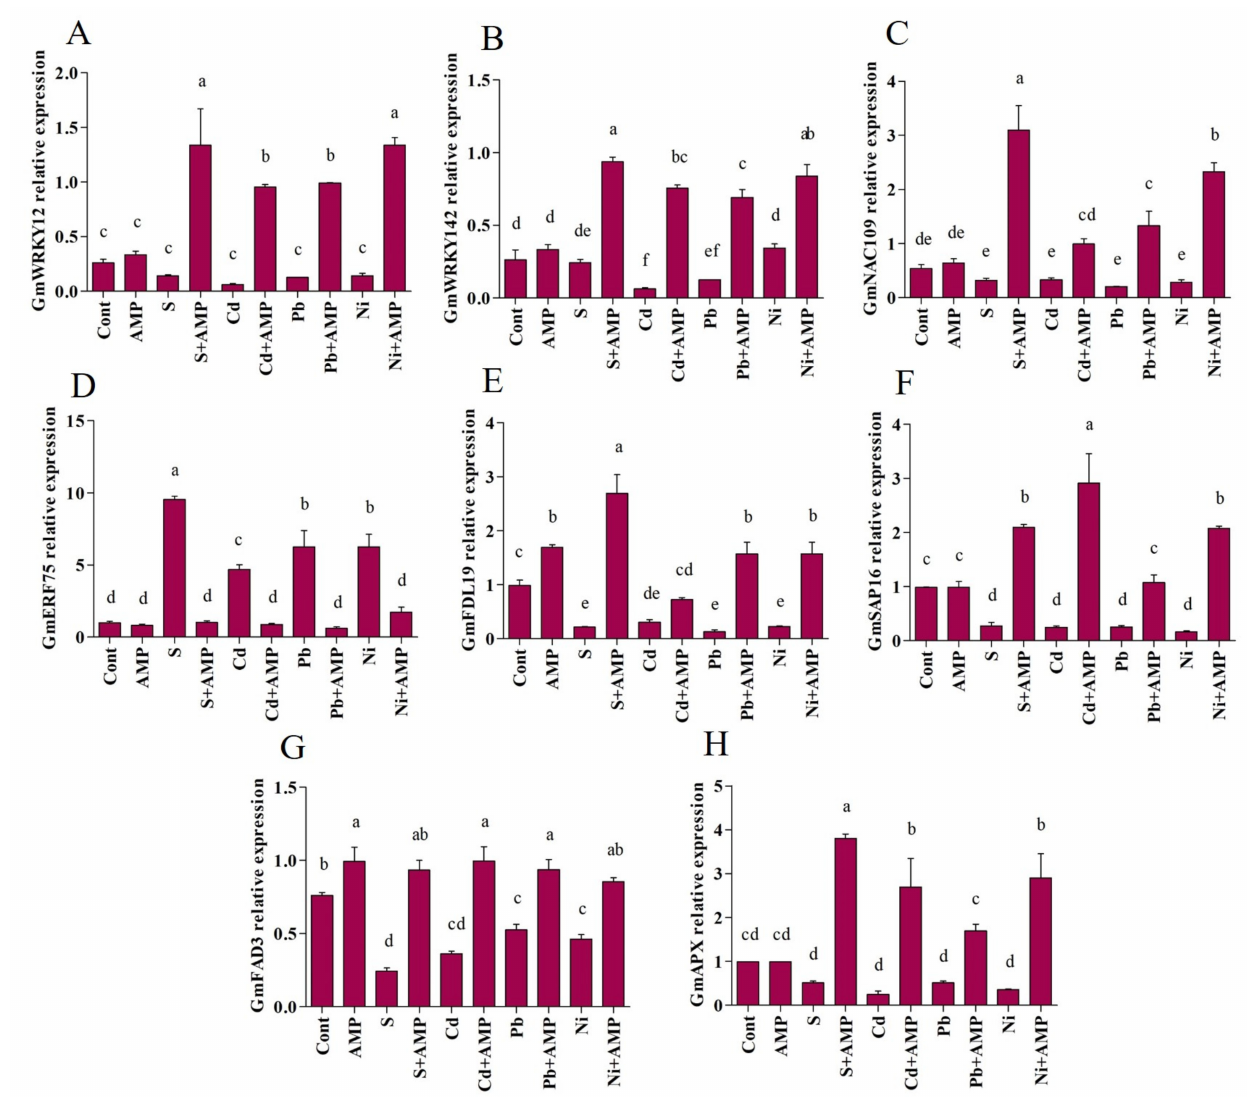
Figure 6. Real time expression analysis of WRKYs GmWRKY12, ( A ); and GmWRKY142, ( B ); GmNAC109, ( C ); GmERF75, ( D ); GmFDL19, ( E ); GmSAP16, ( F ); GmFAD3, ( G ); and GmAPX ( H ) in leaves of soybean grown under normal and stress conditions and treated with ampelopsin after 12 days (12DAT). Treatment: Cont (control), AMP (1 µ M ampelopsin), S (1.5% sodium chloride), AMP (1 µ M ampelopsin) + S (1.5% sodium chloride), Cd (3 mM cadmium), 1 µ M AMP (ampelopsin) + Cd (3 mM cadmium), Pb (3 mM lead), AMP (1 µ M ampelopsin) + Pb (3 mM lead), Ni (3 mM nickel), and AMP (1 µ M ampelopsin) + Ni (3 mM nickel). Values show the means ± SE ( n = 5) and significant differences at p < 0.05 (Tukey test). Bars with different lowercase letters are significantly different from each